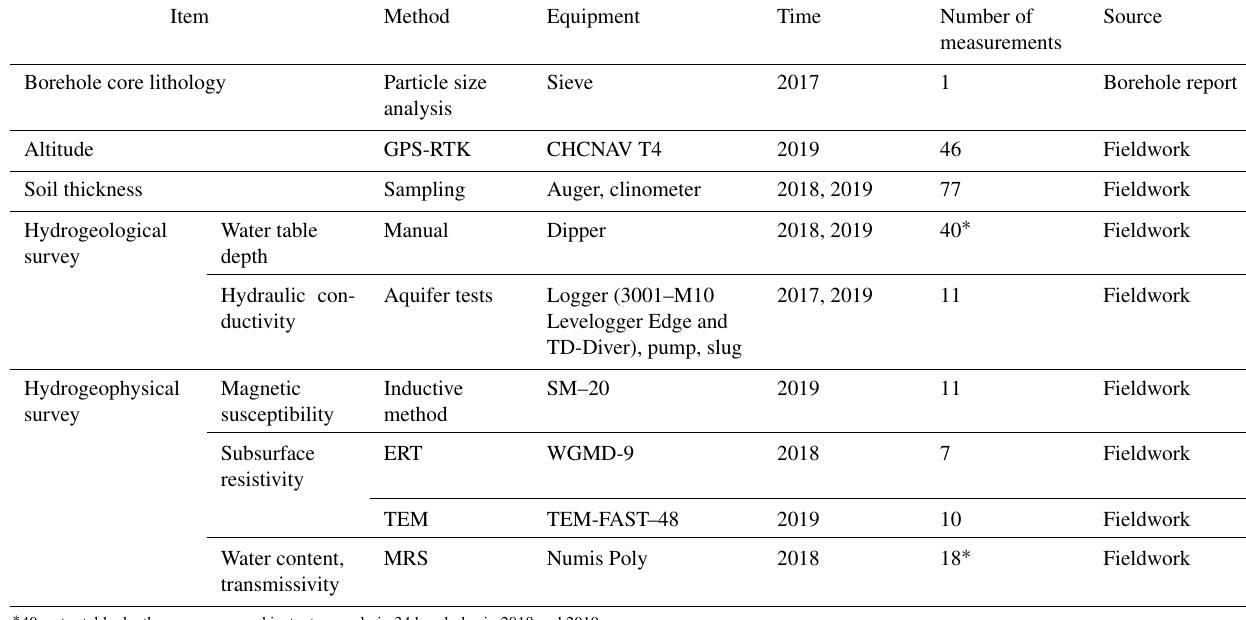
Table 1. Methods, equipment, and timing for carrying out relevant measurements as in Fig. 2.